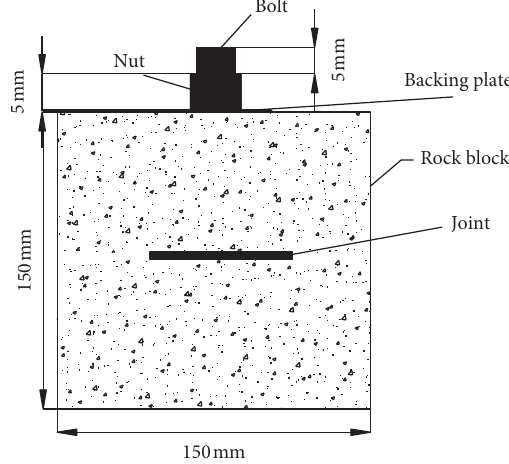
Figure 4: Diagram of typical joint specimens.